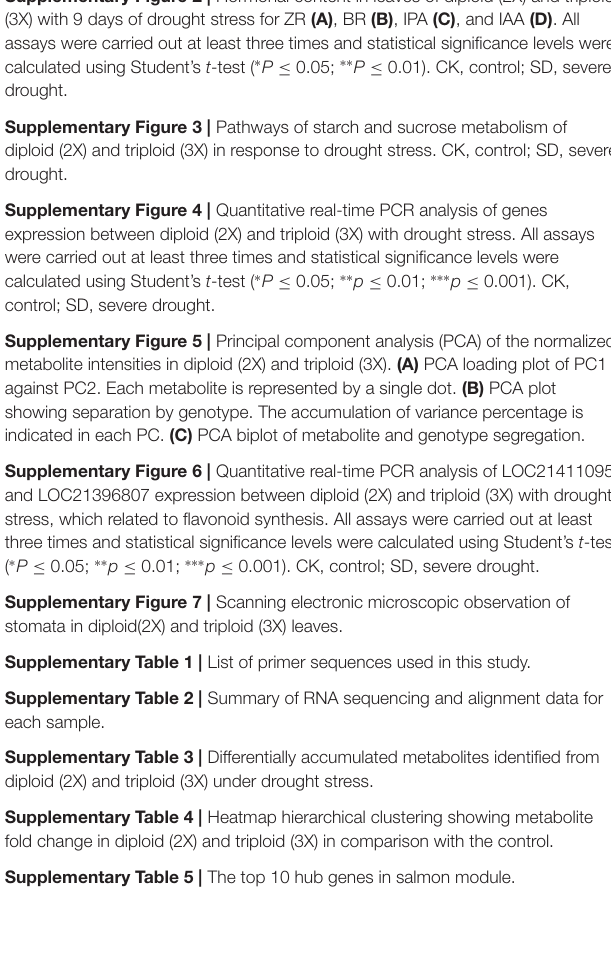
Supplementary Figure 1 | Phenotype and flow histogram of plants (A) Normal growing and drought stressed of Shinichinose (2X), Shaansang-305 (3X) cultivated for 15 days. Flow histogram of (B) Shinichinose (2X) and autotriploid species of (C) Shaansang-305 (3X). Supplementary Figure 2 | Hormonal content in leaves of diploid (2X) and triploid (3X) with 9 days of drought stress for ZR (A) , BR (B) , IPA (C) , and IAA (D) . All